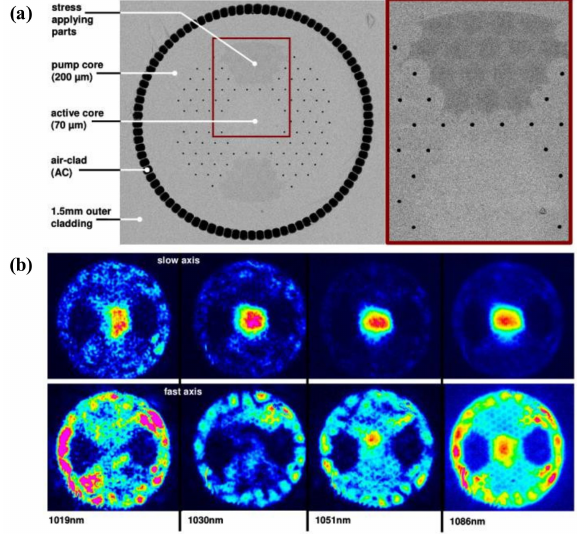
Figure 11. ( a ) Schematic diagram of the fiber structure ( b ) near-field intensity distribution of the slow (upstream) and fast axes at four different wavelengths